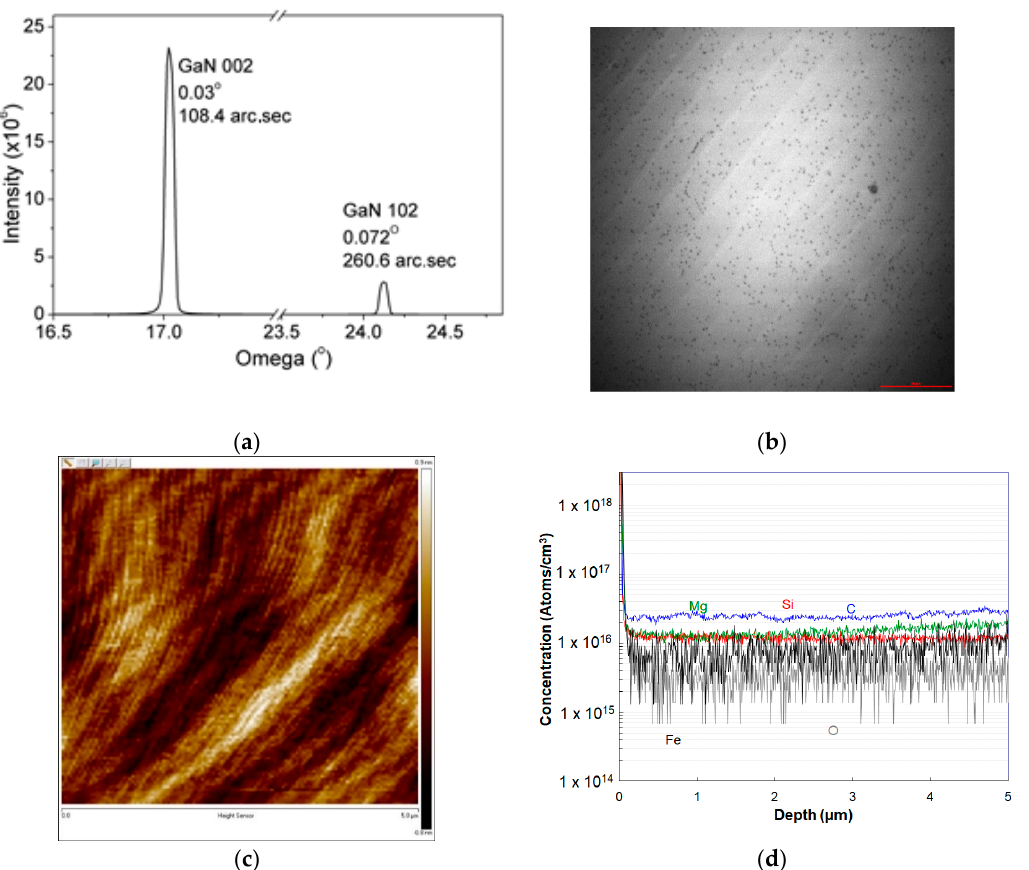
Figure 8. ( a ) X-ray diffraction (XRD), ( b ) TDD (MPPL), ( c ) Atomic force microscopy (AFM) and ( d ) SIMS Characteristics of the wafer. Table 4. Material properties of MOCVD grown GaN drift layers (DL)s such as 2 theta-omega scan, root mean square (RMS) surface roughness, TDD, elemental concentrations and charge carrier density (CCD) measured by SIMS (Si limit 1.0 × 10 14 and Mg limit 2.0 × 10 14 ) and Hall.